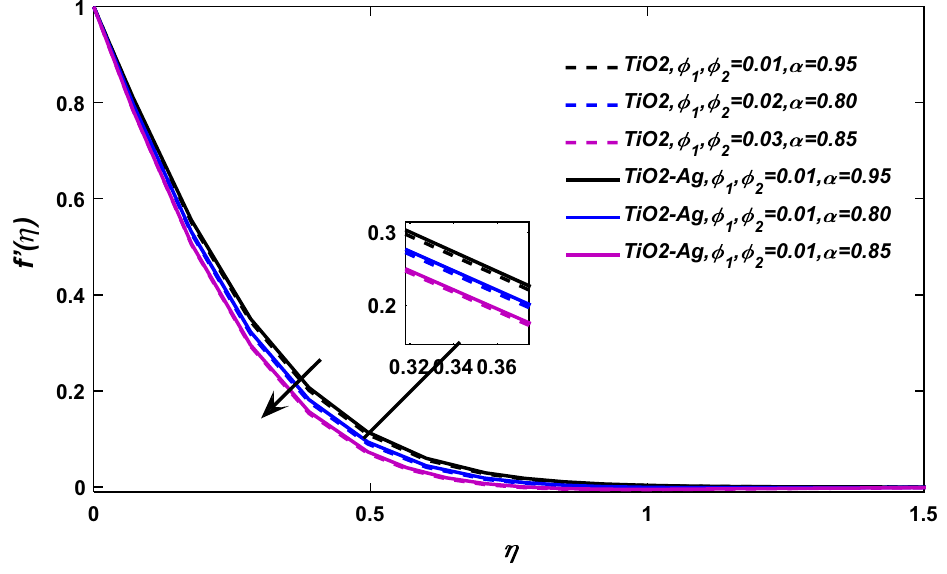
Figure 4. φ 1 , φ 2 versus velocity field when α = 0.95, 0.90.0.85, (cid:31) = 0.01, E = M = 0.1, Pr = 21.